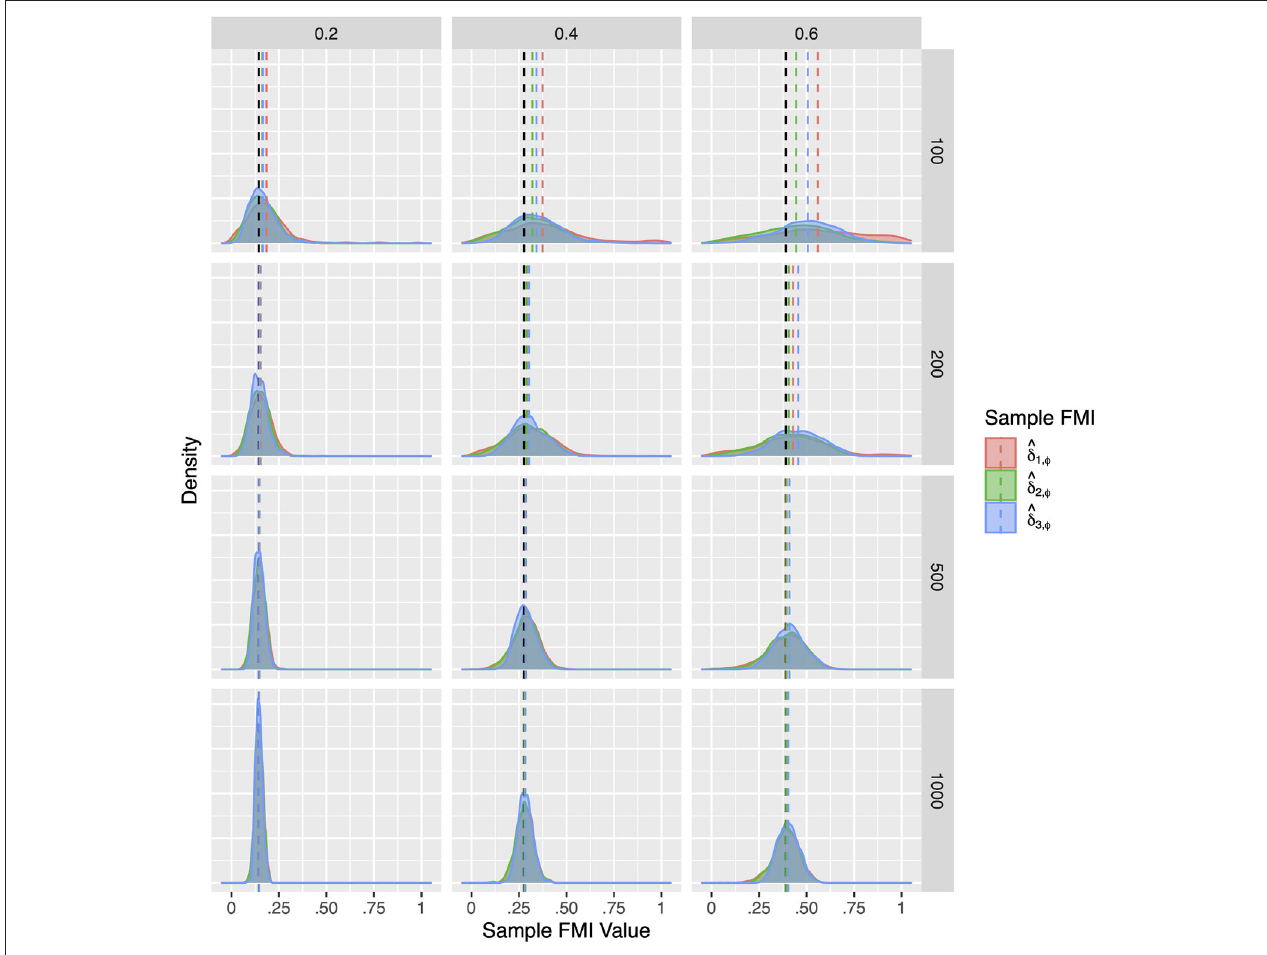
FIGURE 6 | The sampling distribution of FMI for factor correlations in nonlinear MAR. The panel rows correspond to sample sizes of N panel columns correspond to per variable missing rates of 20, 40, and 60%, or overall population missing rates of 10, 20, and 30%. The population FMI value in each panel is given as a vertical black dotted